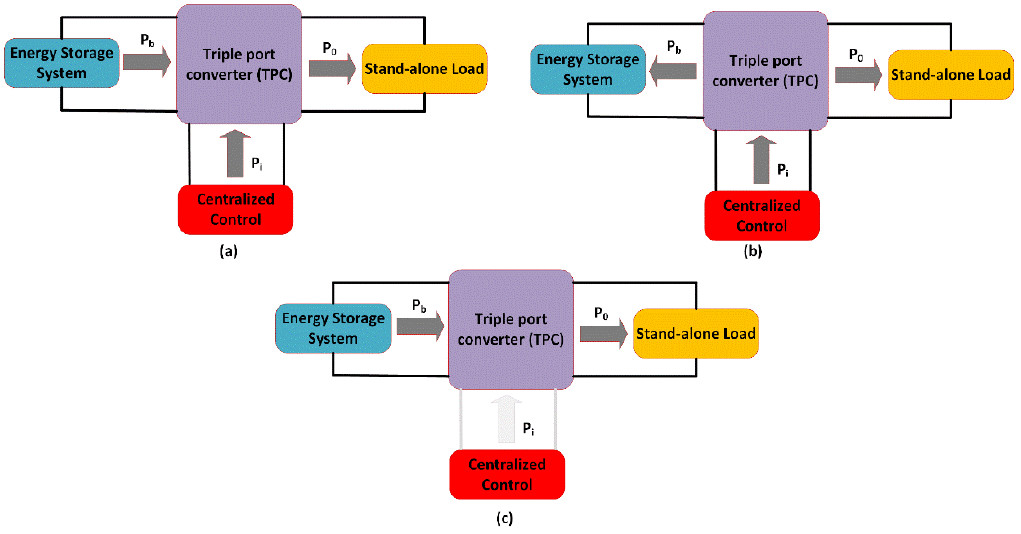
Figure 22. Operating modes of the TPC ( a ) DISO ( b ) SIDO ( c ) SISO.